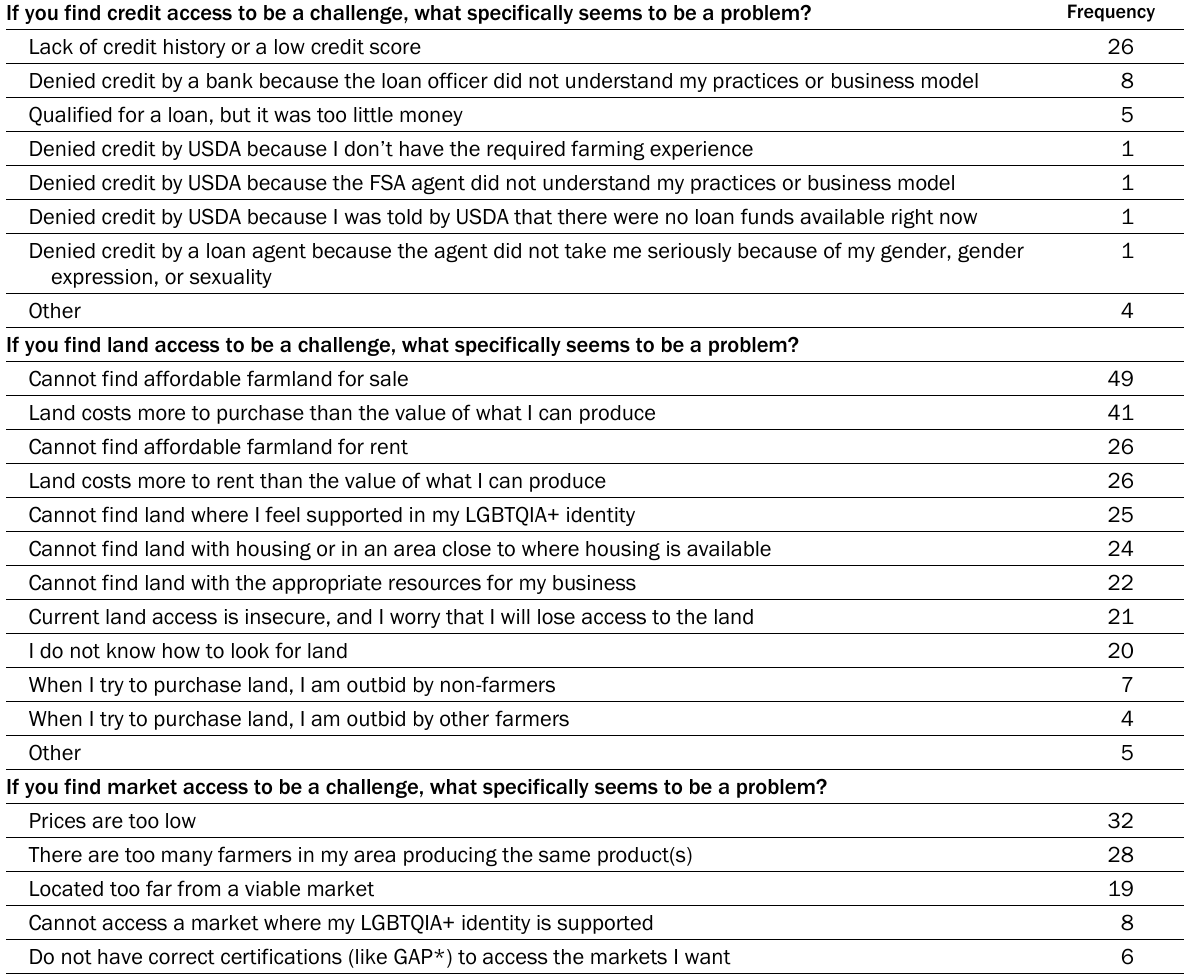
Table 4. Credit, Land, and Market